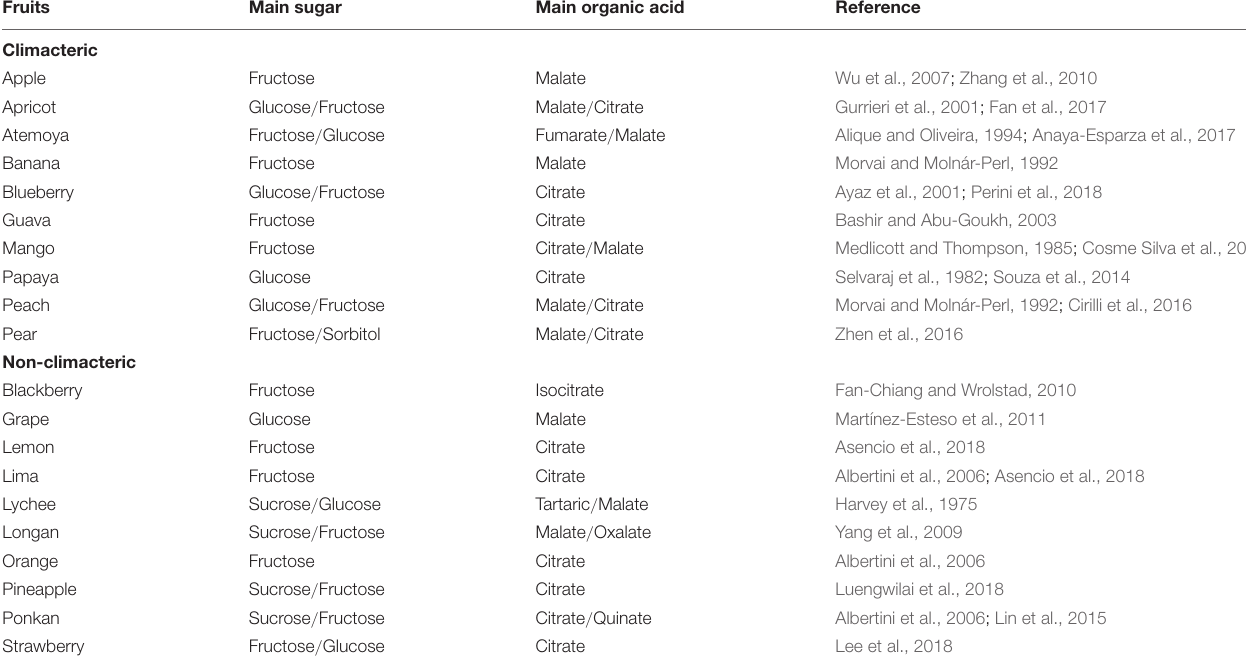
TABLE 1 | Main sugars and organic acid found in both climacteric and non-climacteric ripe fruits.